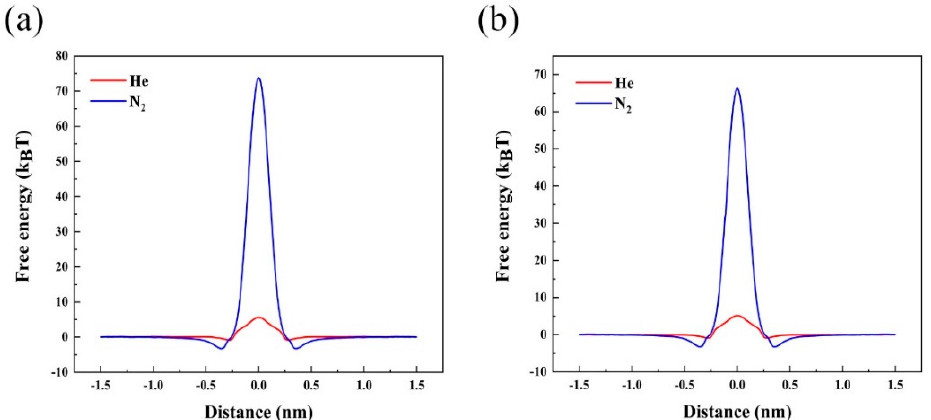
Figure 5. The PMF of He and N 2 passes through the ( a ) Fe-PTC and ( b ) Ni-PTC membranes by umbrella sampling.